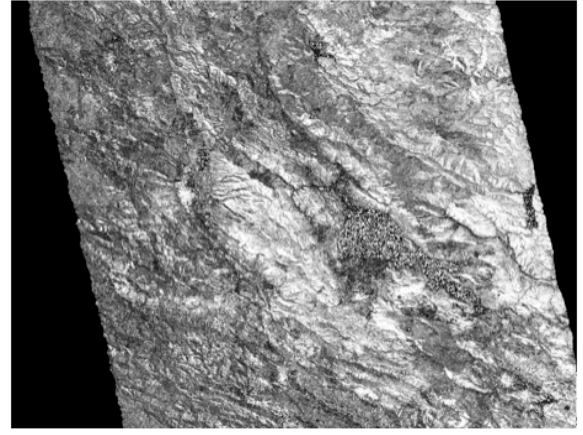
Figure 5. Correlation Map.